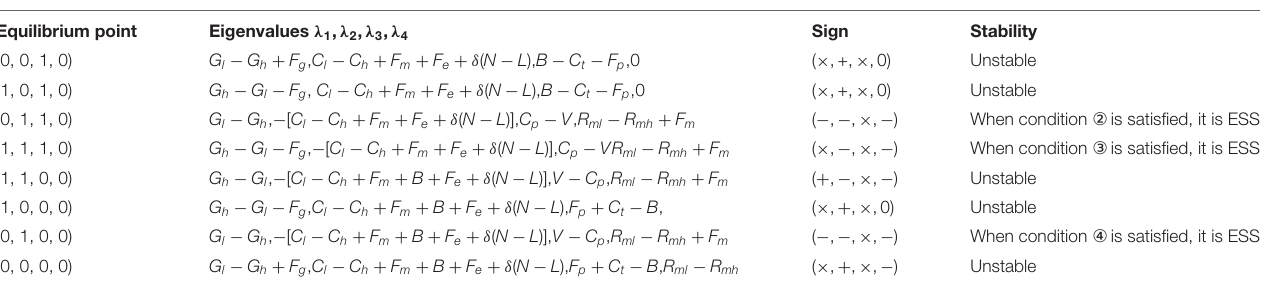
TABLE 4 | Asymptotic stability of the equilibrium point in distorted